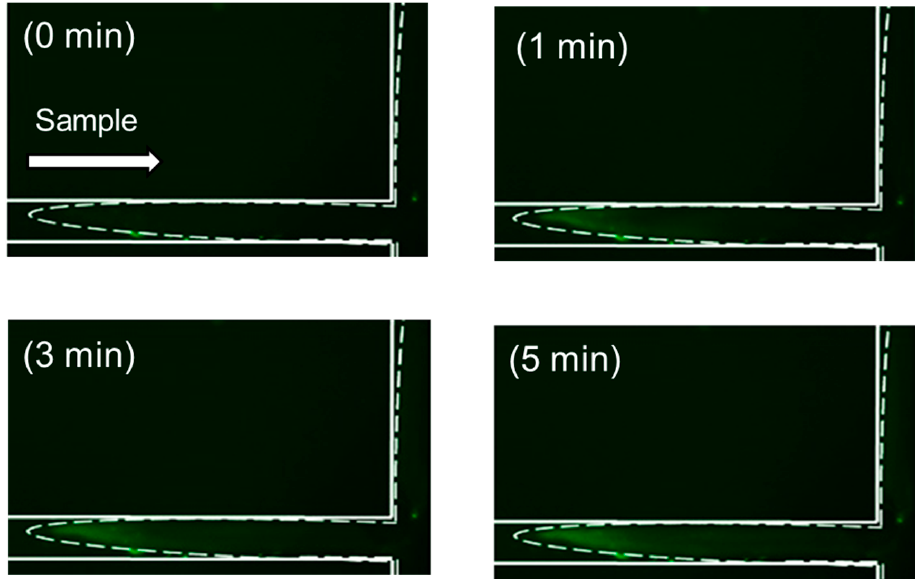
Figure 5. Time-coursed image of fluorescence intensity due to concentration of 10 − 8 M 5-(4,6-dichlorotriazinyl)aminofluorescein (DTAF)-labeled monophosphorylated β -casein at the channel crossing in the polydimethylsiloxane/glass microchannels in the presence of in situ fabricated Phos-tag acrylamide